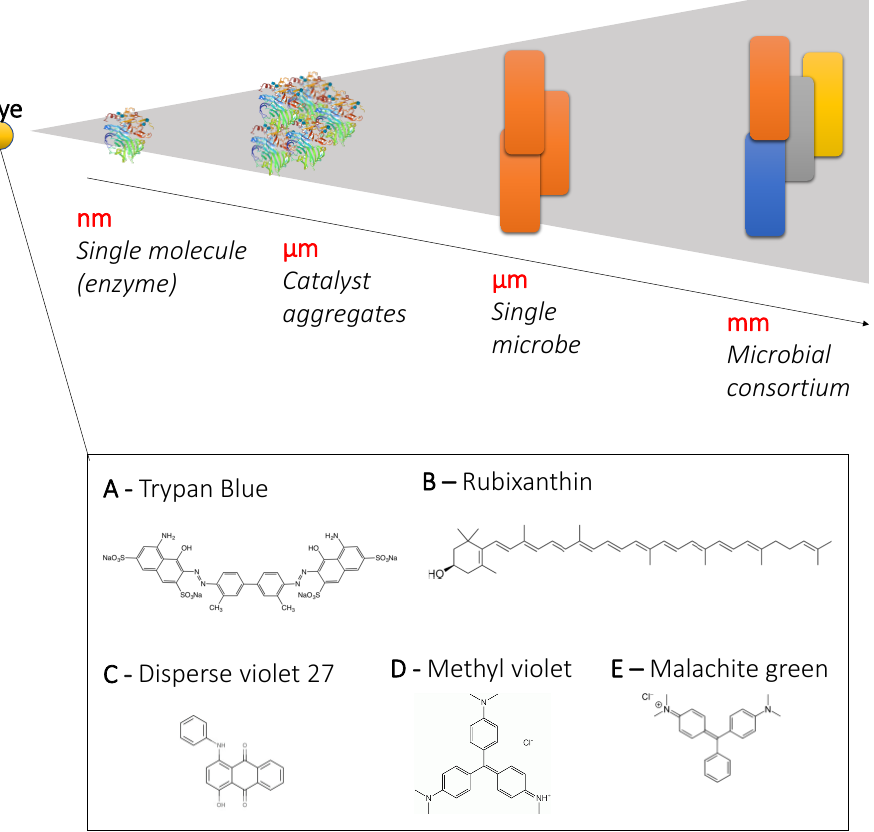
Figure 2. Multi-scale dimension of the biotech-based solutions to improve the sustainability of col- orants. Biotechnological solutions encompass a wide range of dimensions, from the nanometer-scale of single proteins, e.g., laccase (PDB ID: 1KYA), to the millimeter-size of complex microbial commu- nities that provide a whole enzymatic toolbox for bioremediation. (Lower panel) Representative colorants used on the industrial scale. (A) Trypan Blue is an example of azo dyes, organic molecules characterized by the functional group R – N=N –R′, currently applied to cotton coloration on a large scale but also applied to laboratory analytics. (B) Rubixanthin is a carotenoid, and carotenoids from waste from tomato processing are being tested for dyeing silk, wool, and polyamide [28] to provide a yellow coloration. (C) Disperse violet 27, or 1-anilino-4-hydroxyanthraquinone belongs to the ani- line group of colorants and has been tested with polylactide fabrics. It is used in cosmetics but not allowed for products in contact with mucous membranes. (D) Methyl violet is a family of dyes that has been the subject of extensive studies focusing on adsorption and bioremediation [29]. (E) Mala- chite green is a chemically formed triarylmethane dye that is recognized by laccase.